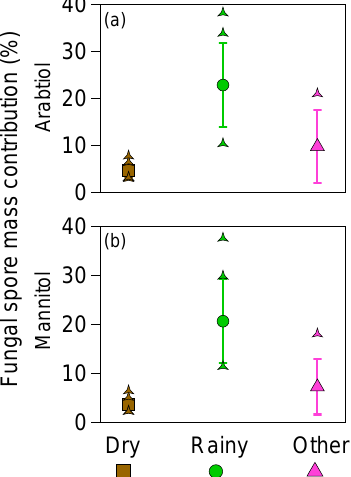
Figure 7. Estimated fraction of total aerosol mass contributed by fungal spores. Fungal spore mass concentration (µgm − 3 ) calcu- lated separately from mannitol and arabitol concentration and using average mass per spore reported by Bauer et al. (2008b). Total par- ticulate matter mass calculated from UV-APS number concentration (m − 3 ) and converted to mass over aerodynamic particle diameter range 0.5–15µm using density of 1.5gcm − 3 . Central marker shows mean value of individual filter concentration values, bars represent standard deviation (SD) range of filter values, and individual points show outliers beyond mean ±